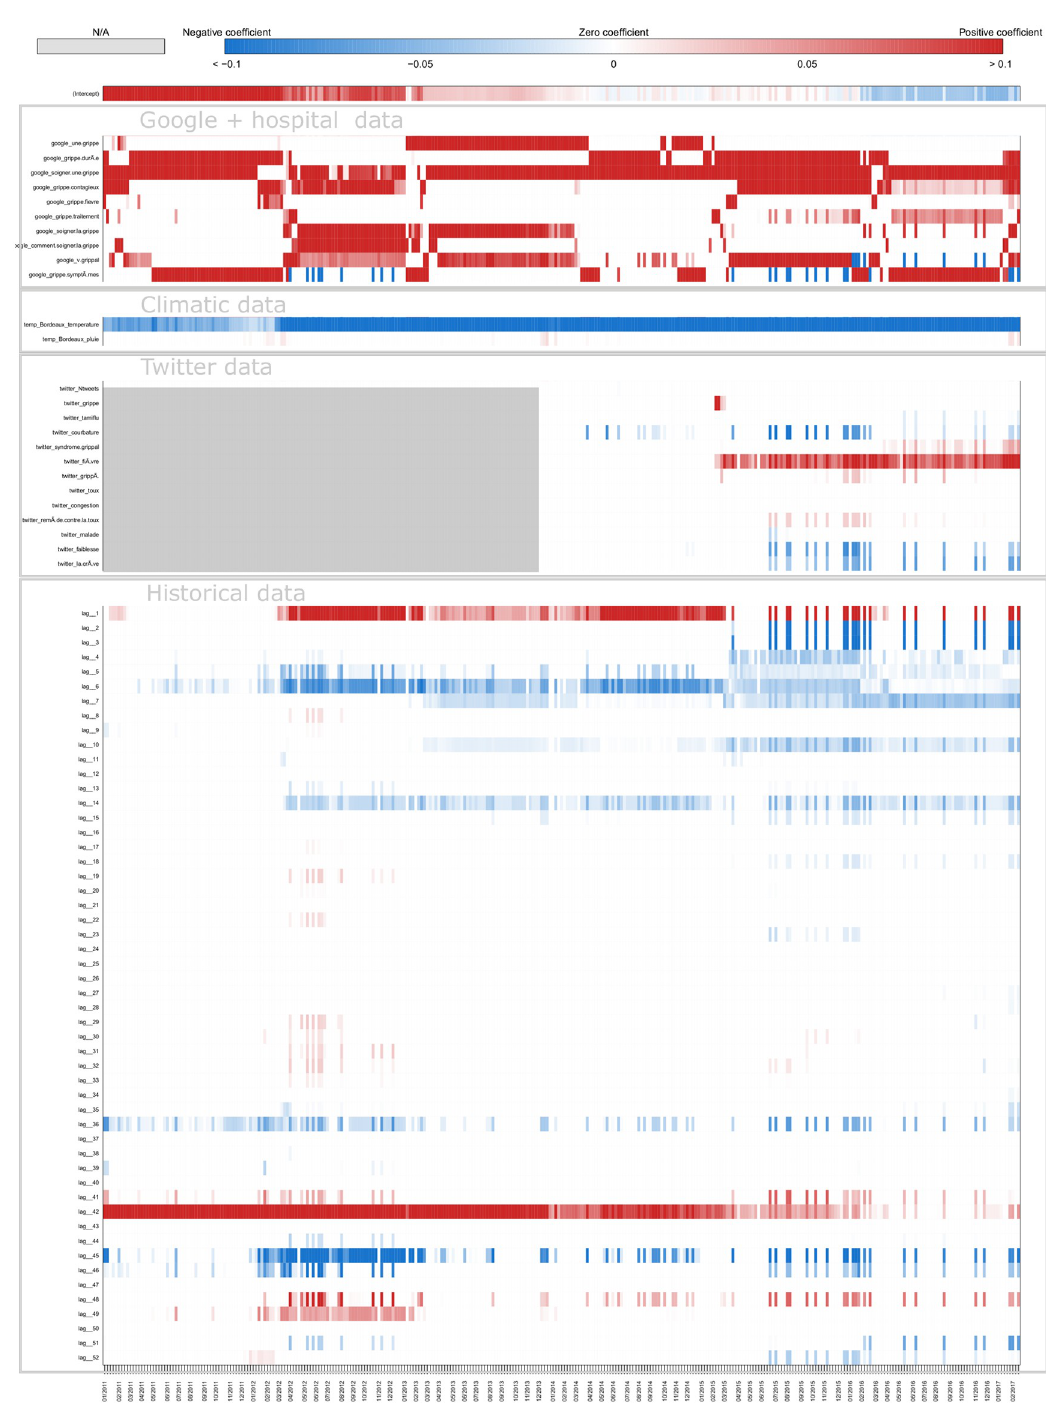
Fig 13. Visualization of correlation and errors obtained for two-week ahead estimate with each model.